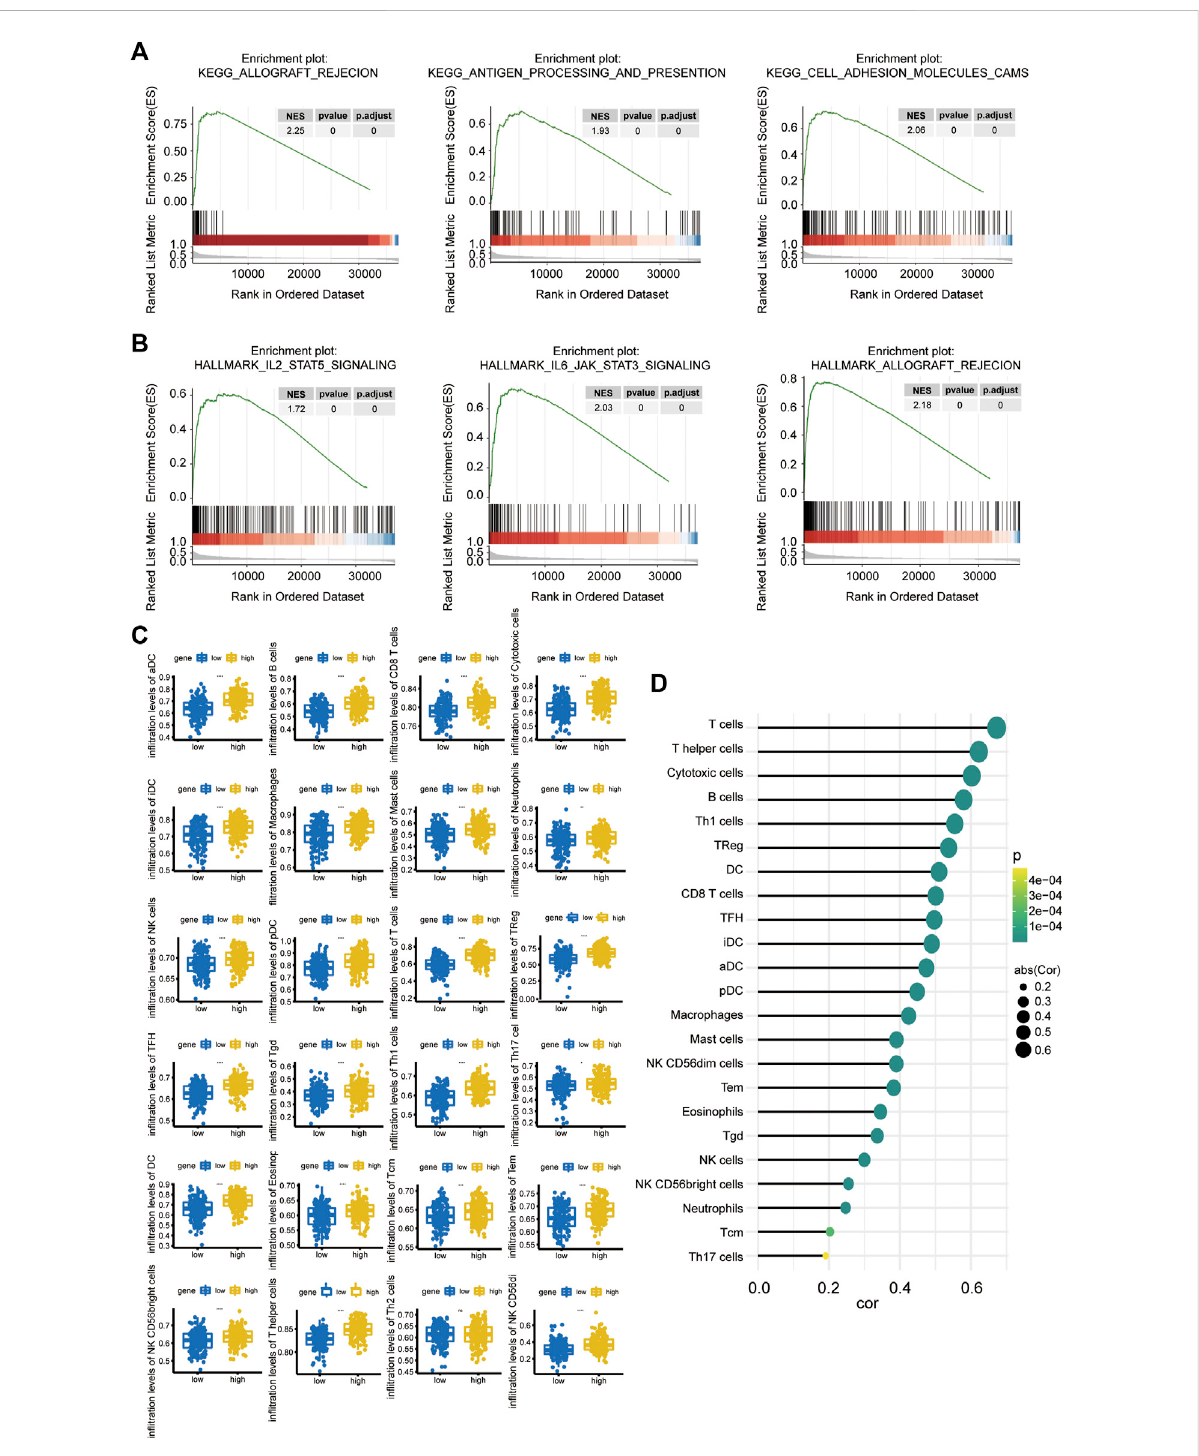
FIGURE 5 (A,B) GSEA of Linc00996 ( KEGG pathway in the upper row and the hallmark pathway in the lower row). (C) Differences among 22 TIICs. The abscissa represents the high- and low-expression groups, and the ordinate represents immune cells. Blue indicates the low-expression group, and yellow indicates the high-expression group. * p < 0.05, ** p < 0.01, *** p < 0.001, **** p < 0.0001. (D) Correlation between Linc00996 expression and the proportion of signi fi cant immune